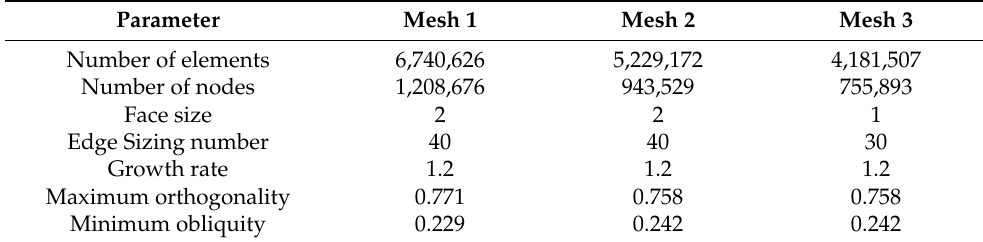
Table 1. Features of three meshes for mesh sensitivity analysis.